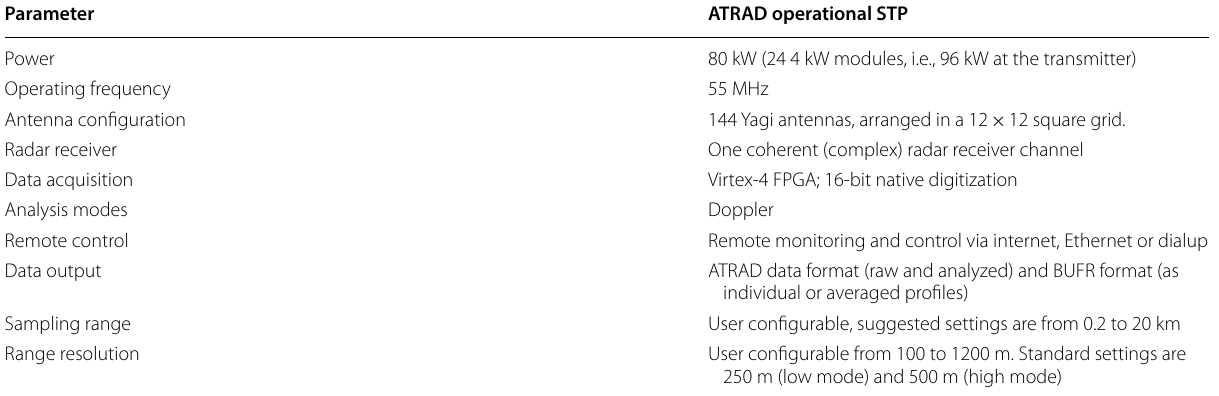
Table 1 Technical specifications of the operational ST system